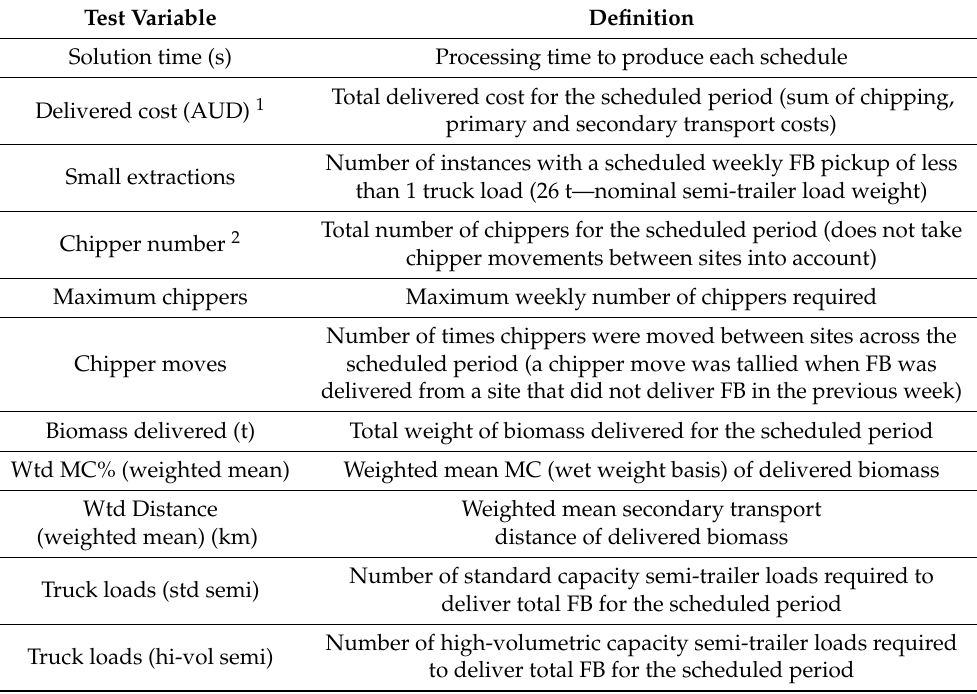
Table 3. Mathematical model comparison test criteria